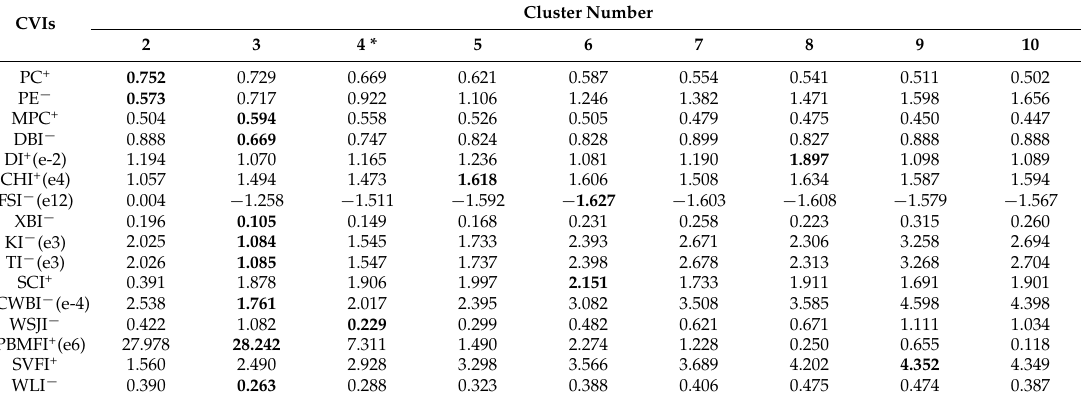
Table 9. Variations of the 16 CVIs with cluster numbers ranging from 2 to 10 for the HYDICE image.